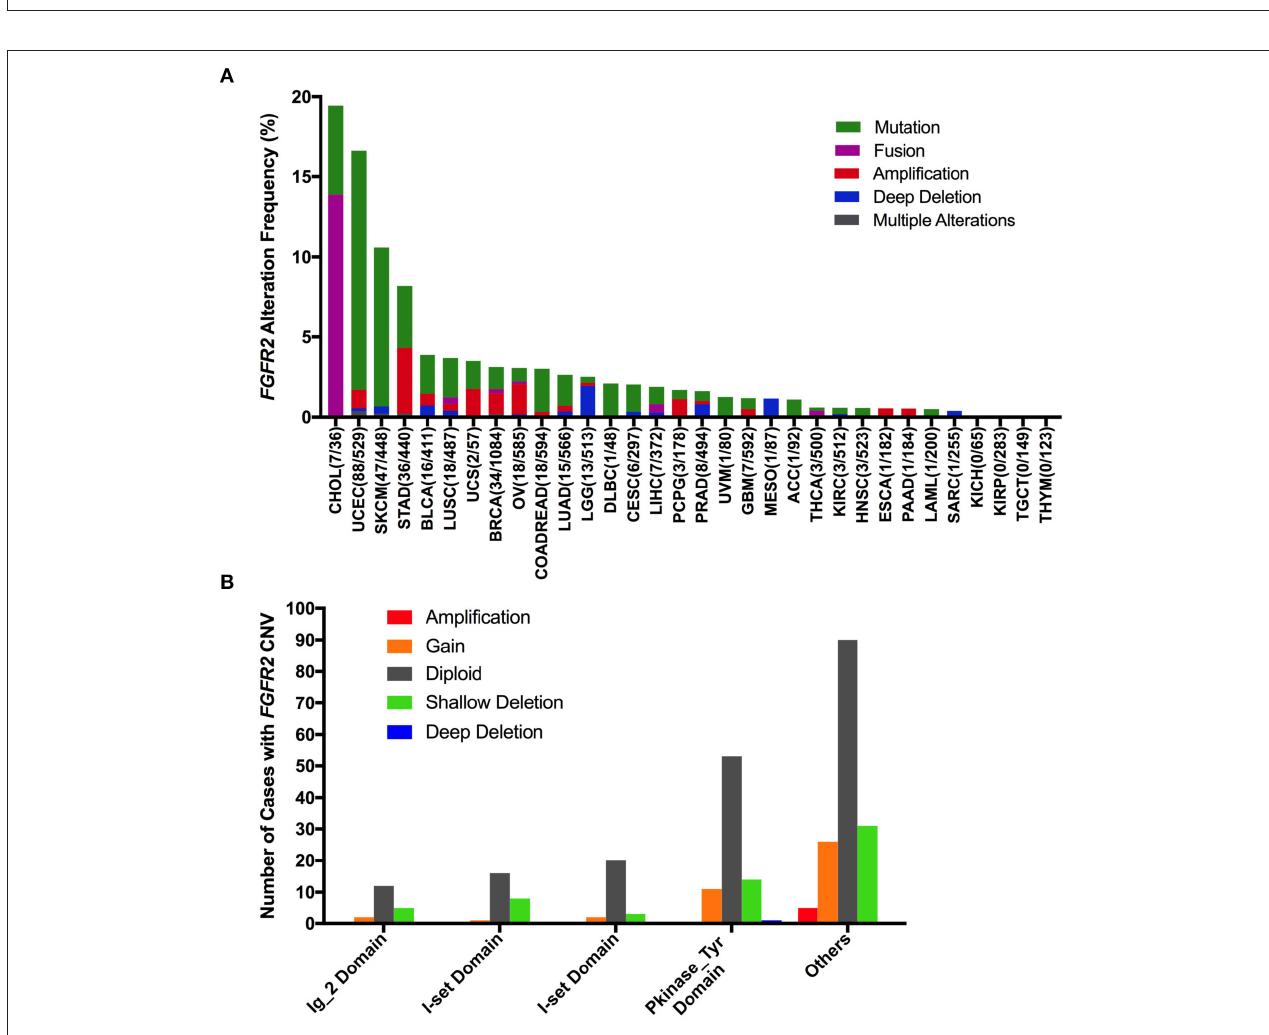
FIGURE 1 | normal tissues in 14 cancer types. Red dots indicate increased methylation in cancers, and blue dots indicate decreased methylation in cancers. (C) Bubble map showing the association between methylation and the expression of FGFR2 and downstream genes across different cancer types. Red dots represent the upregulated methylation level and expression level, and blue dots represent the upregulated methylation level and downregulated expression level. For the point in two bubble map: the size of the point represents statistical significance, where the larger the size, the greater the significance. The color depth of the point represents the difference, where the darker the color, the greater the difference. TPM, transcripts per million.